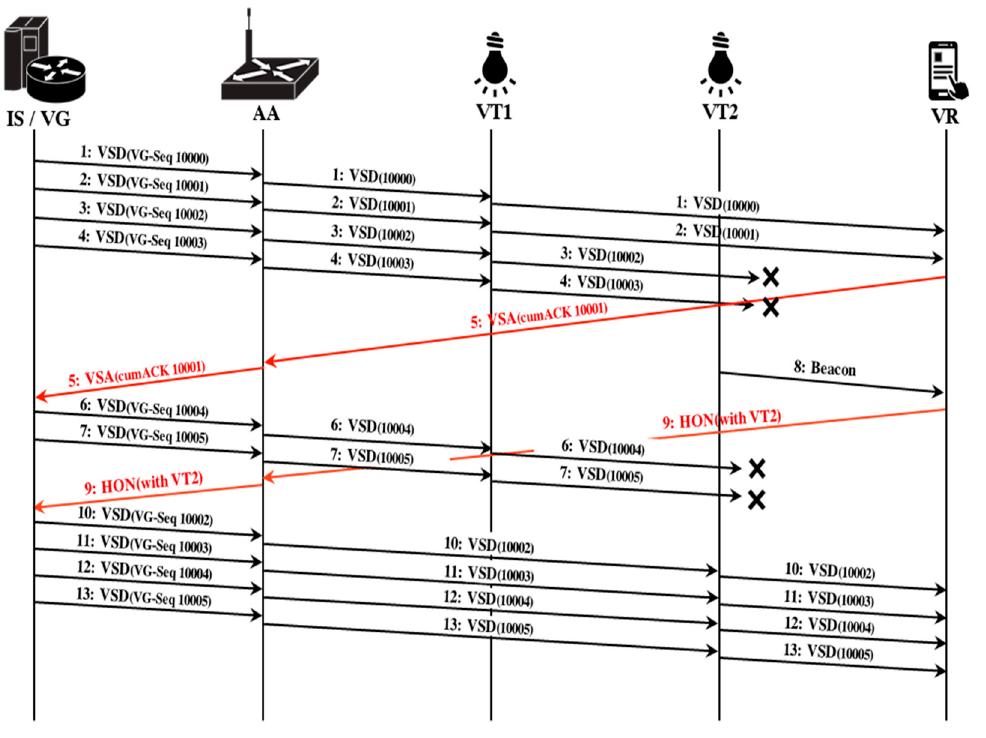
Figure 16. AA handover operations.